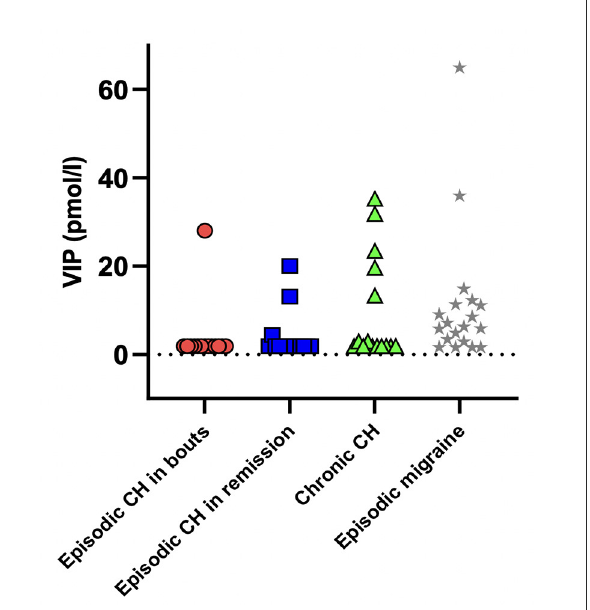
FIGURE6 Individual plasma levels of VIP at the baseline. No significant difference was found among cluster headache patients and a historical group of interictal episodic migraine patients ( p = 0.1161). Mean plasma levels ± standard deviation: eCHA = 3.764 ± 6.976; eCHR = 4.023 ± 5.291; cCH = 9.633 ± 12.010; EM = 11.080 ± 15.200. eCHA: episodic cluster headache in bouts, eCHR: episodic